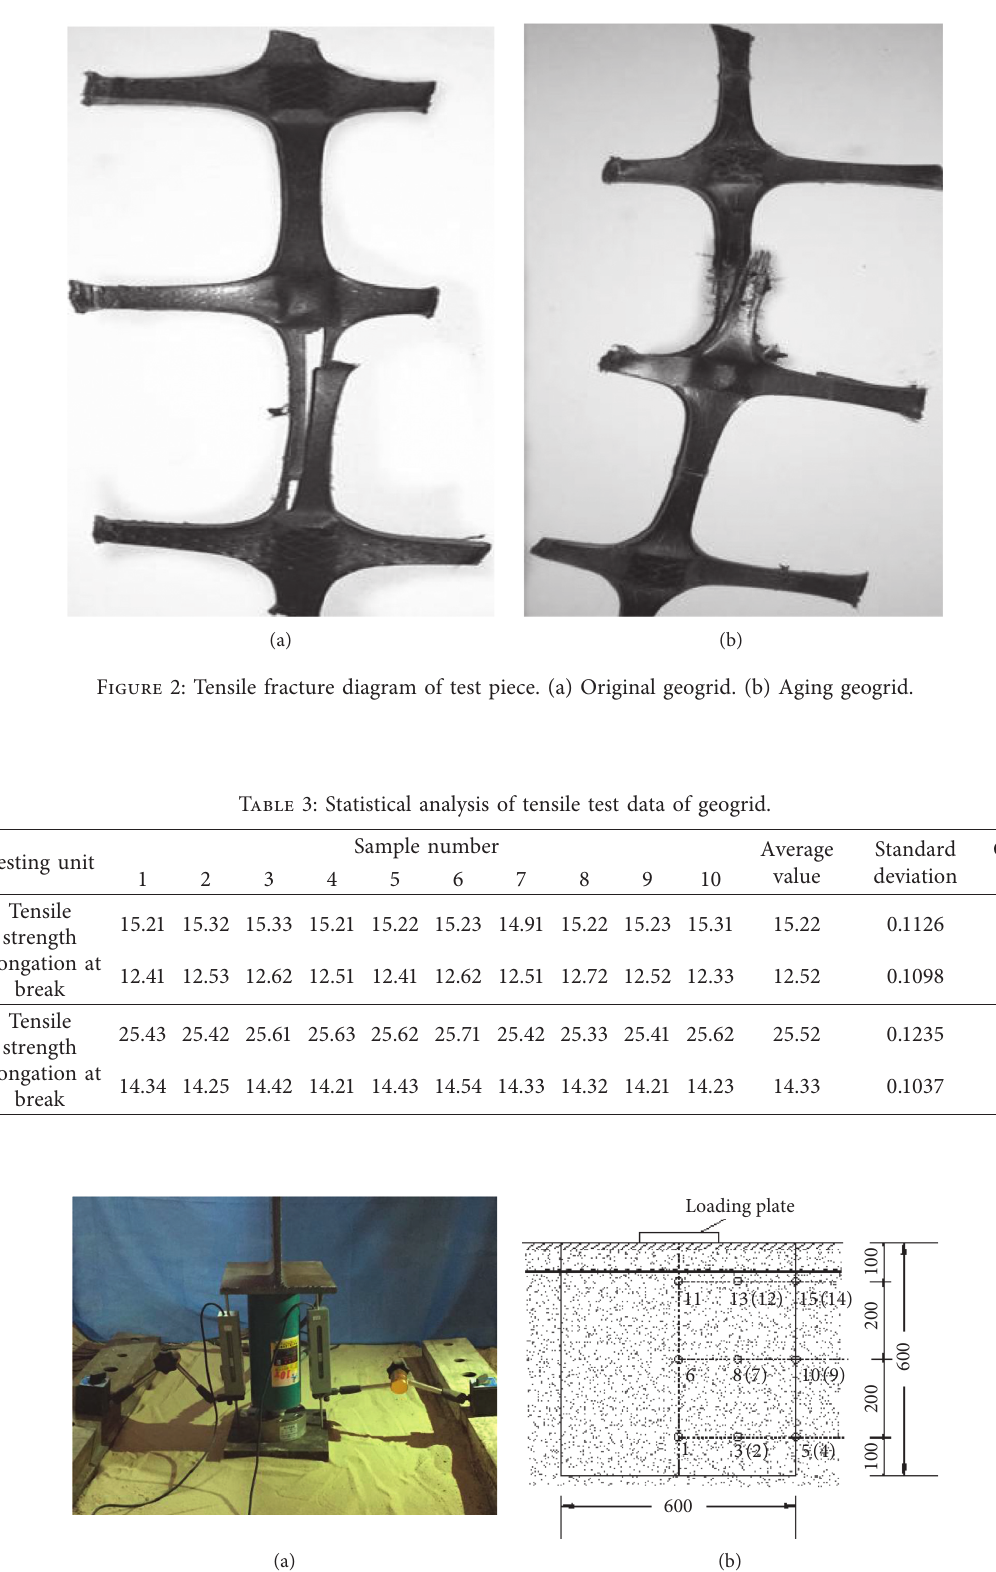
Figure 3: The picture of the model test site and the layout of the Earth pressure box. (a) Picture of the model test site. (b) Layout of soil pressure